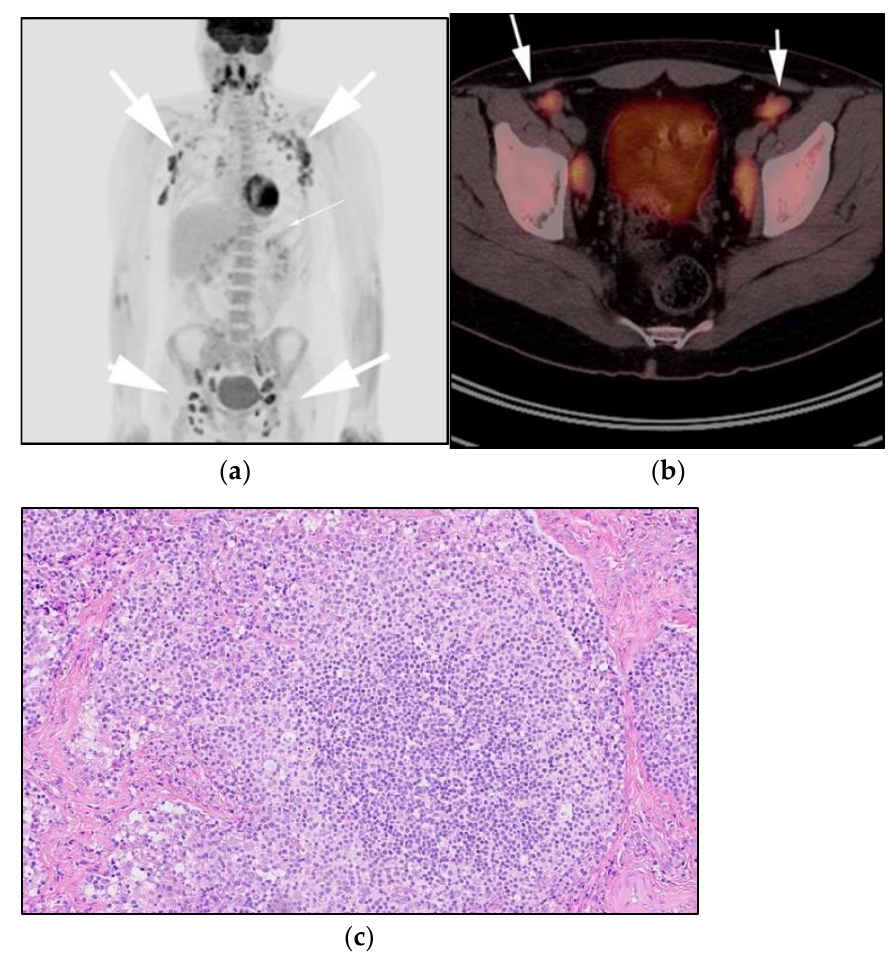
Figure 4. A 30-year-old male with known history of autoimmune lymphoproliferative disorder since childhood. ( a ) Max- imal intensity projection (MIP) FDG PET/CT image shows generalized hypermetabolic lymphadenopathy throughout the head, neck, chest, abdomen, and pelvis (white arrows). Note that splenic activity is not visualized (thin white arrow) because the spleen was surgically removed during childhood due to splenomegaly. ( b ) Axial FDG PET image shows hy- permetabolic adenopathy within pelvis mainly about the bilateral pelvic side wall and external iliac nodes (white arrows). Lymph nodes often show little or only modest uptake, a clue, in addition to stability of nodal size and over multiple time points. Biopsy is the only method for definitive diagnosis. ( c ) H&E section of a lymph node shows highly proliferative paracortical expansion composed of small proliferative lymphocytes and immunoblasts with preserved lymphoid follic- ular architecture. There is sinus histiocytosis. (Original magnification 400×, H&E